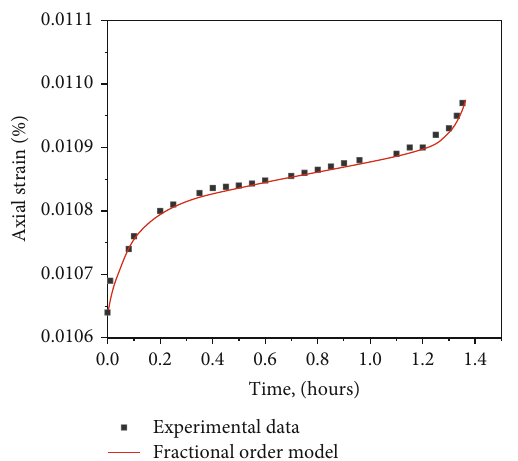
Figure 17: Creep fi tting e ff ect of the mudstone interlayer after oil